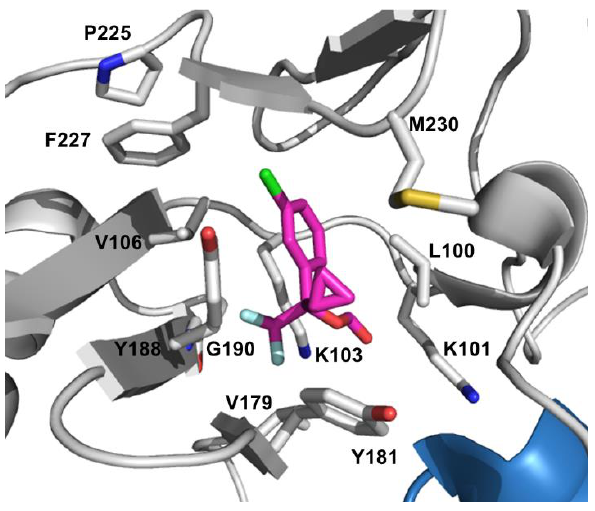
Figure 5. Detailed view of the NNRTI binding pocket. EFV is shown as magenta sticks and the EFV-resistant mutation sites are shown in white sticks. PDB 1FK9